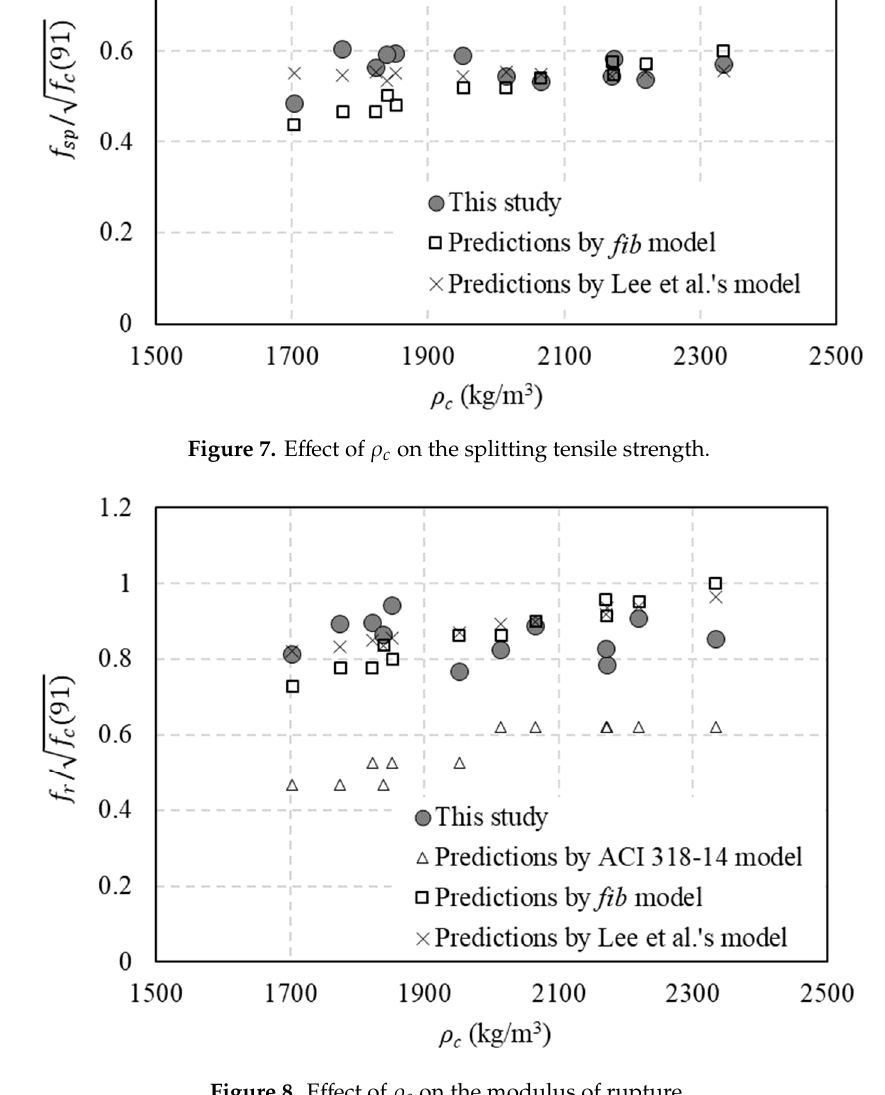
Figure 8. E ff ect of ρ c on the modulus of Figure 8. Effect of ρ c on the modulus of rupture. Figure 8. Effect of ρ c on the modulus of rupture.